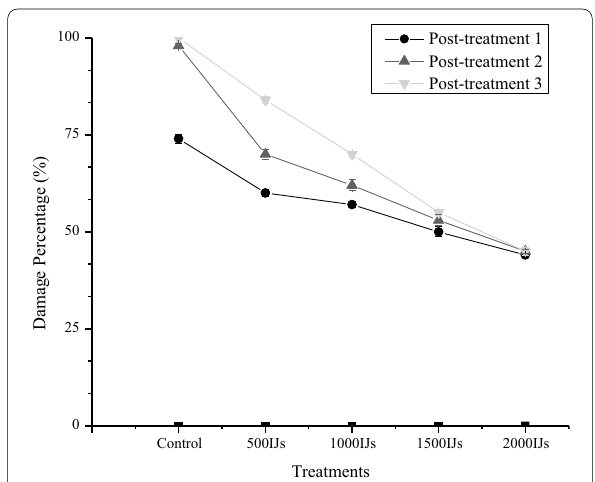
Fig. 4 Damage percentage and cabbage productivity after three applications of Heterorhabditis bacteriophora EUPT-S26 against